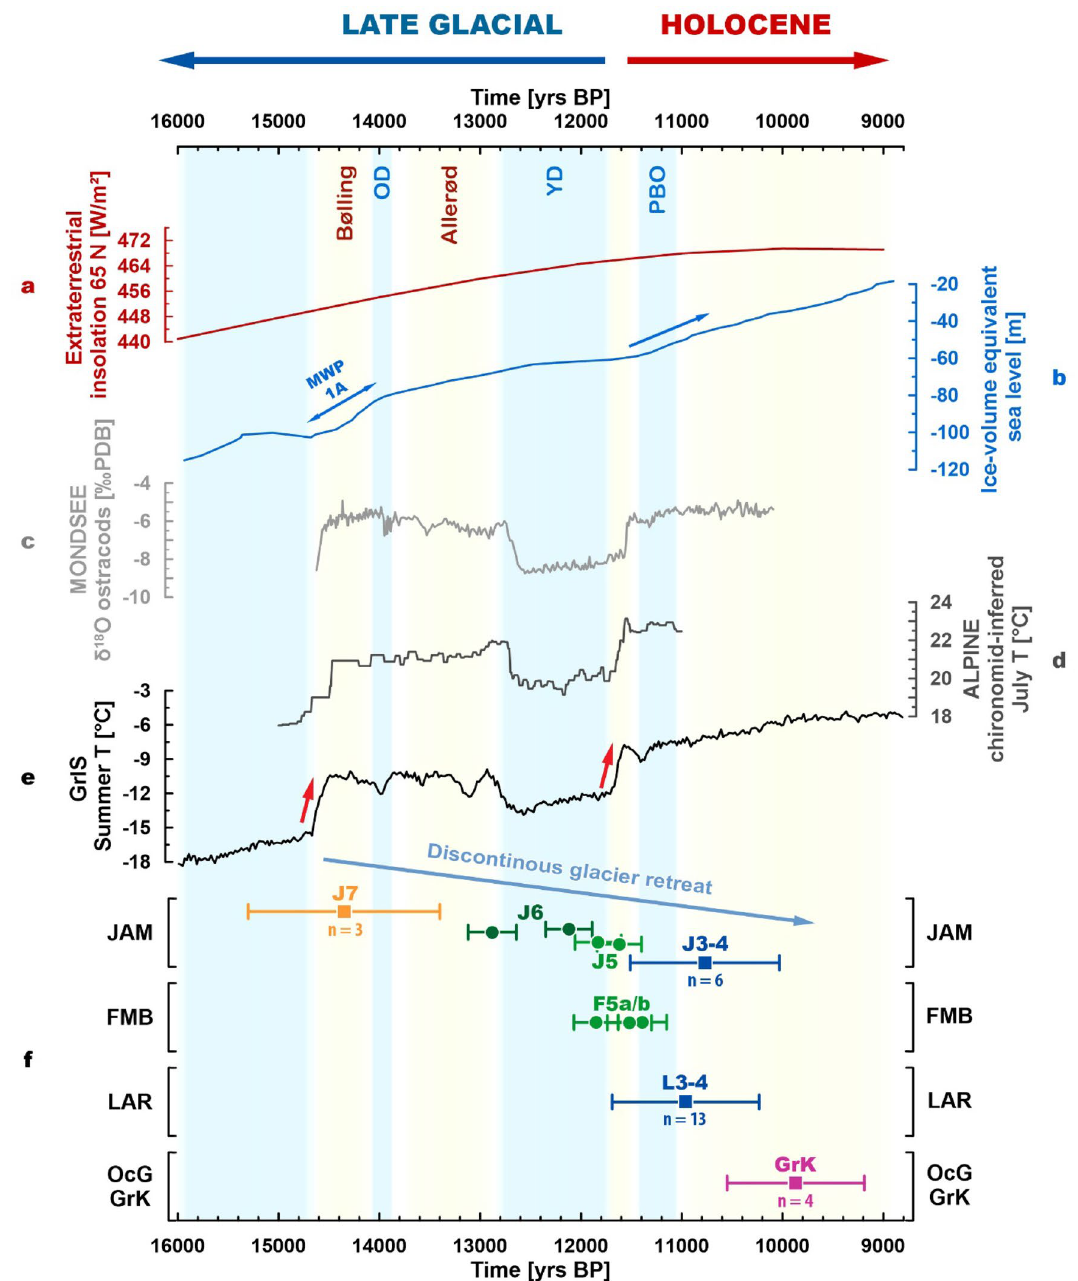
Figure 7. Silvretta mountain glacier records correlated with solar insolation, sea-level rise, and climate proxy records from different regions in the Northern Hemisphere. (a) Insolation at 65 N 40 gradually increases during the LG and is a natural forcing for climate warming during this period. (b) Global sea-level rise due to deglaciation of the cryosphere 41 ; note increased rate of change between 14.5 and 14 ka, and 11.4 ka onwards. (c) Local high-resolution ostracod record from lake Mondsee 42 . (d) Chironomid-inferred summer temperature stack record for the Alpine region 43 . (e) Summer temperatures from the Greenland Ice Sheet (GrIS) reconstructed based on oxygen isotopes in Greenland ice cores 44 . Temperatures reconstructed using different methods and representing different spatial scales in the Northern Hemisphere agree well and capture the YD stadial as well as the two bracketing episodes of rapid climate warming, the pre-Bølling to Bølling transition and the YD–EH transition. (f) Glacier stabilization during general LG warming is indicated by moraines deposited during Oldest Dryas to Bølling transition (J7), the YD (Egesen moraines J6, J5, and F5a/b), and the EH (J3–4 and L3–4) in this study and Braumann, et al. 9 . By 10 ka, Silvretta glaciers have retreated to positions that resemble (subsequent) LIA extents indicated by the 10 Be moraine record in the adjacent Ochsental 19 . Moraine ages (n ≥ 3) are shown with rectangles and individual boulder ages with circles. Kernel plots of moraine ages are provided in the supplement (Fig. S1). For the spatial context of the displayed 10 Be records, see Figs. 1b and